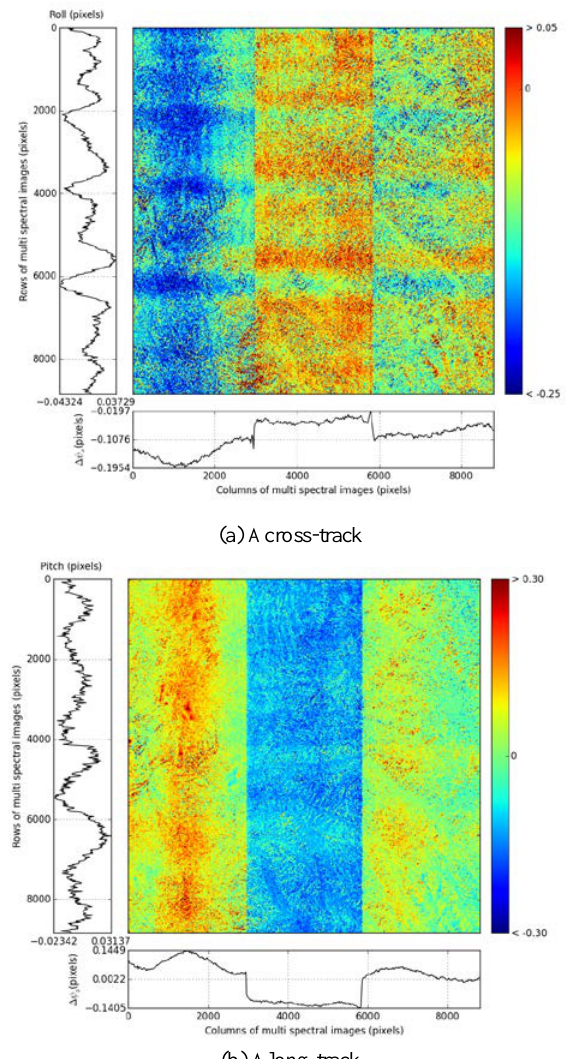
Figure 6 Band-to-band misregistration of Faizabad dataset with penalized